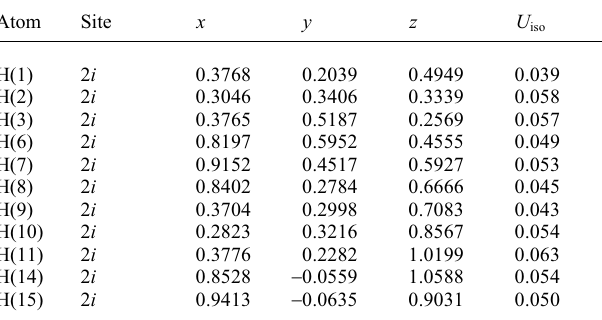
Table 2. Atomic coordinates and displacement parameters (in Å 2 )